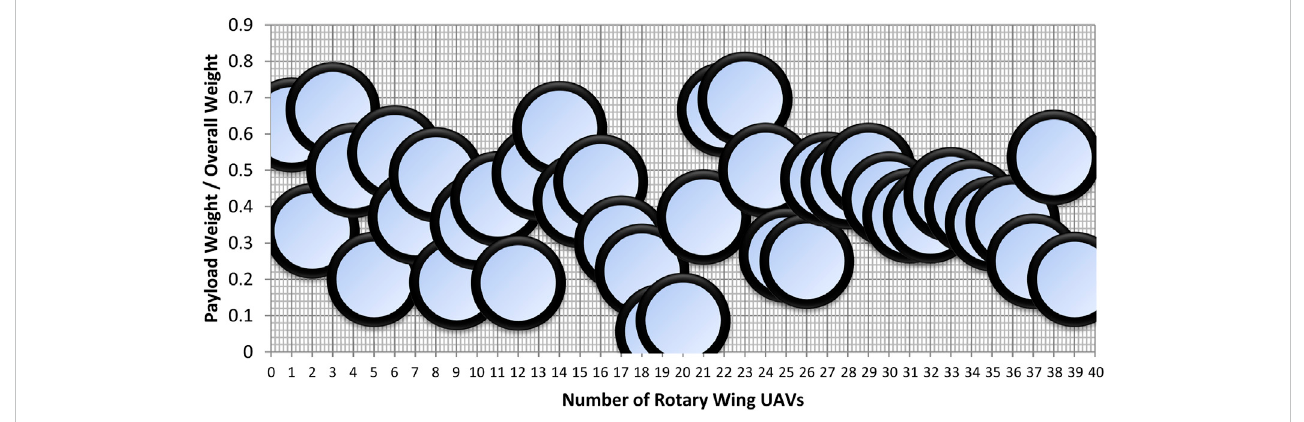
Historical relationship derived for proposed rotary wing UAV.